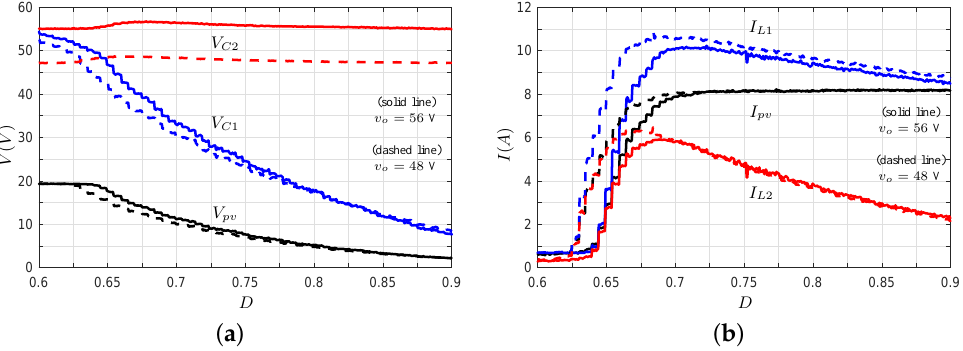
Figure 17. Currents and voltages in the converter. ( a ) Voltage at the terminal of the PV module: capacitor C 1 and capacitor C 2 . ( b ) Current generated by the PV module: inductor L 1 and inductor L 2 .